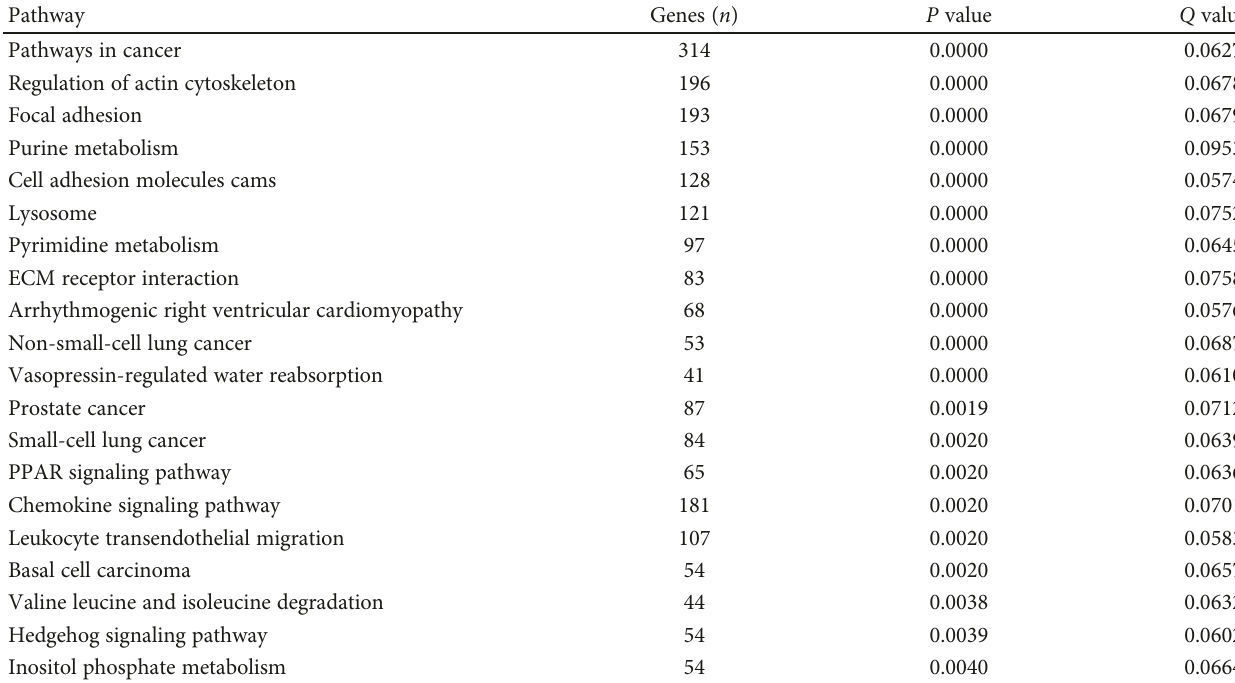
Table 3: Gene set enrichment analysis (GSEA) of ITGA9 mRNA pro fi ling results in HCC from the TCGA database.